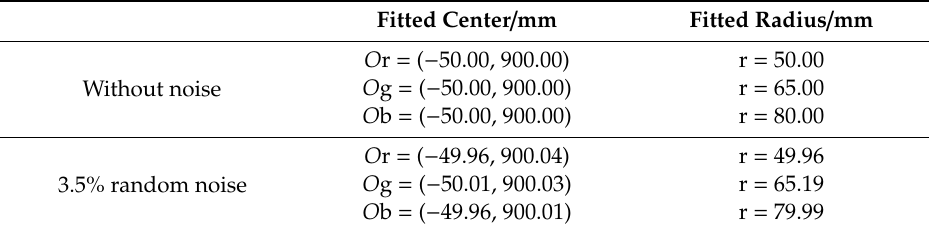
Table 2. Fitted centers and radii correspondence table.